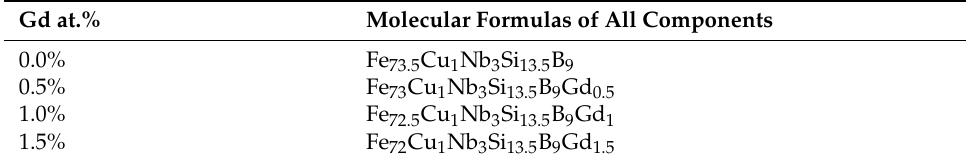
Table 1. The numbers of moles of all components. Gd at.% Molecular Formulas of All